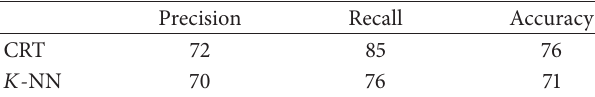
Table 5: Results of the classification procedures (rounded percent-